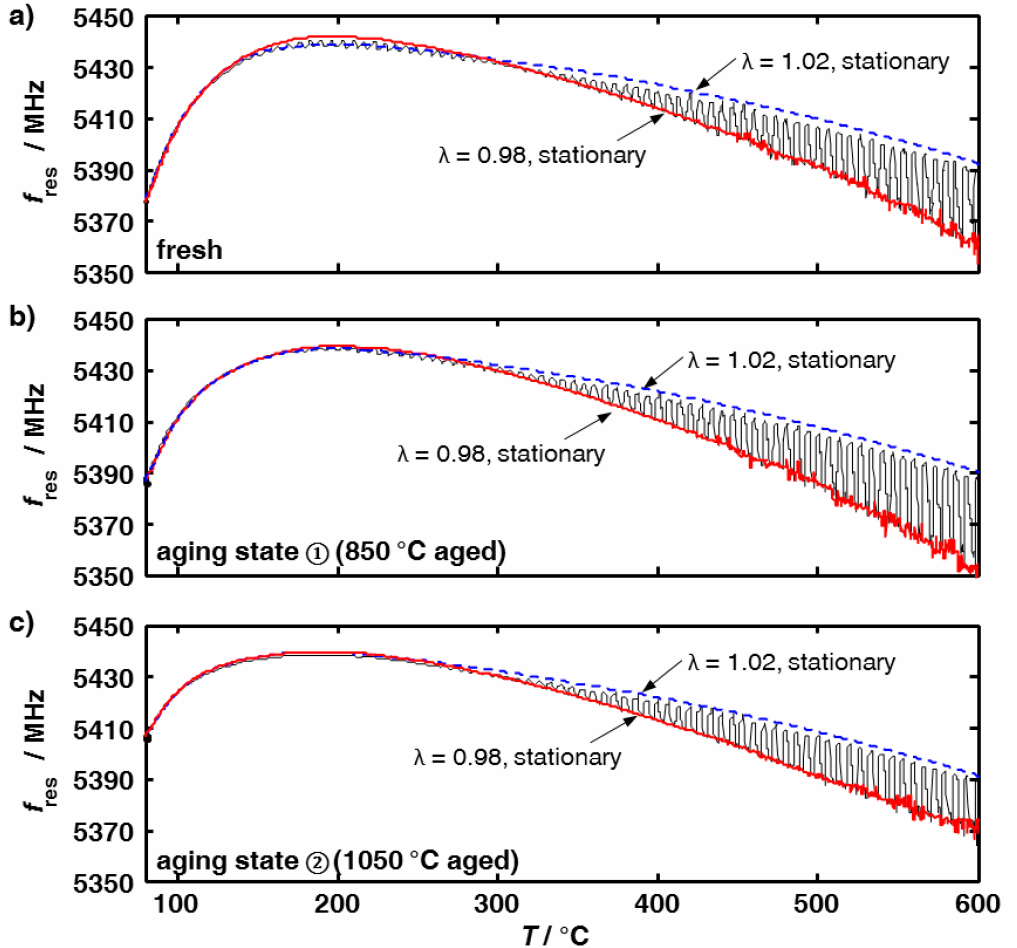
Figure 2. Resonance frequencies of a fresh and aged TWC samples at constant feed gas composition with λ = 1.02 ( dotted blue line ) and λ = 0.98 ( drawn red line ) and with alternating λ ( black line ) during light-off tests: ( a ) fresh sample; ( b ) aging state ① (850 °C, 12 h); and ( c ) aging state ② (1050 °C, additional 12